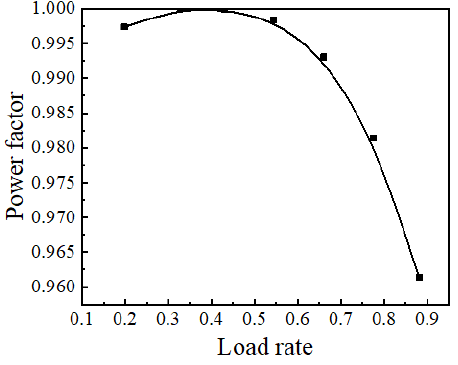
Figure 27. The load test of the prototype.